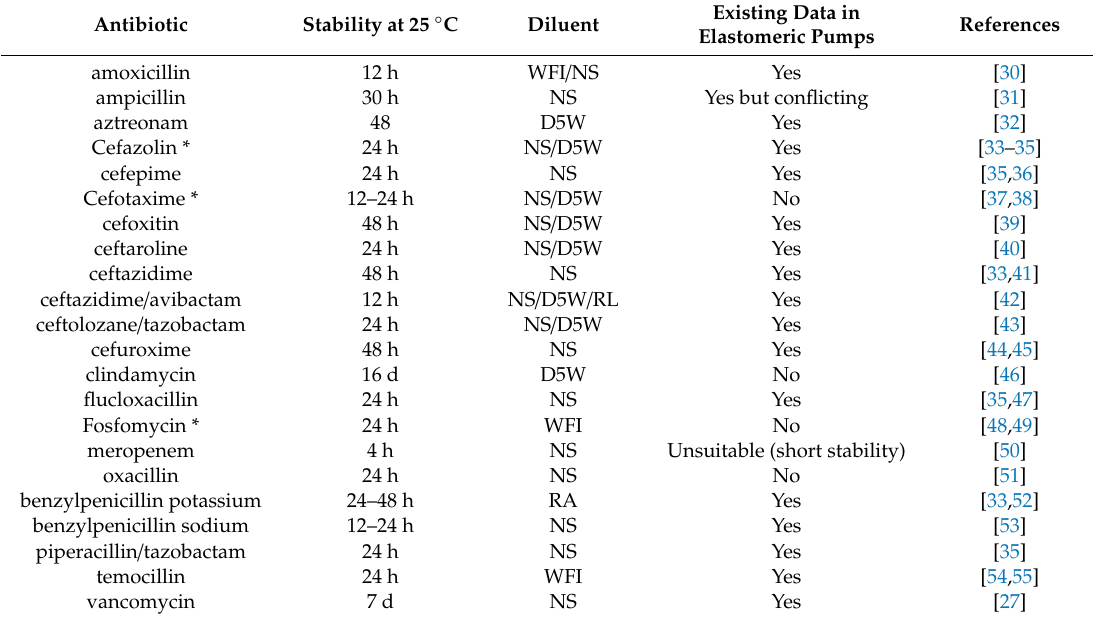
Table 3. Common antimicrobials used for continuous